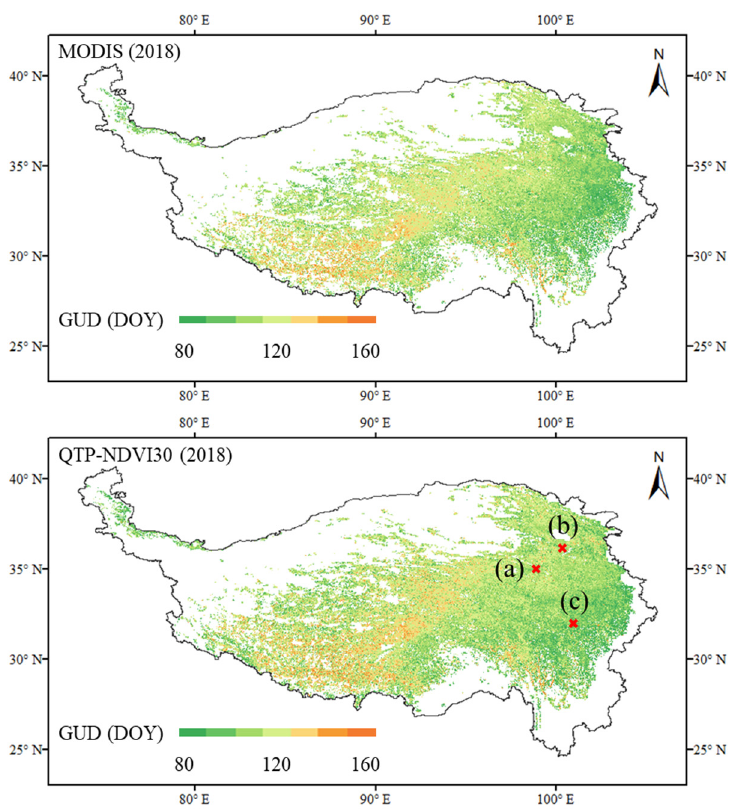
Figure 9. The green-up date (GUD) estimated from 250 m MODIS NDVI time-series ( upper ) and QTP-NDVI30 data ( lower ) in 2018 for the QTP. The three local areas (points a–c) are enlarged and shown in Figure 10. Note: pixels without obvious seasonal NDVI changes were excluded from GUD estimates.